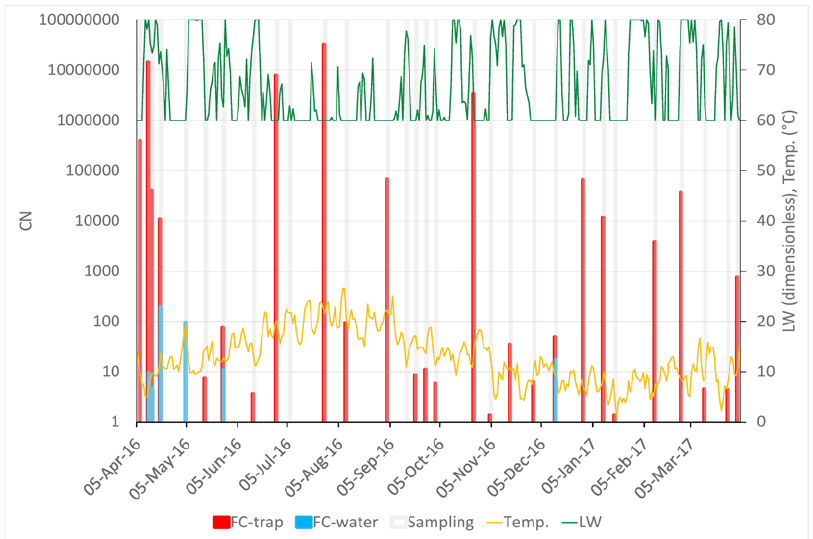
Figure 2. Variation of meteorological variables and abundance of Fusarim circinatum spores across the whole sampling year. The X-axis shows the progress of time. “FC-trap” values (left Y-axis, red columns) display the number of copies of the target sequence in 1 μ L of template DNA (CN) in a logarithmic scale and reflect the amount of F. circinatum inoculum trapped by the rotating arm spore trap. “FC-water” values (left Y-axis, blue columns) display the CN detected in the samples of rain water. Grey columns mark the 30 sampling periods across the whole year. Temperature (“Temp.”, yellow line, °C) and leaf wetness (“LW”, green line, scaleless; 60 = dry, 80 = absolutely wet) are shown on an average daily basis and scaled by the right Y-axis.